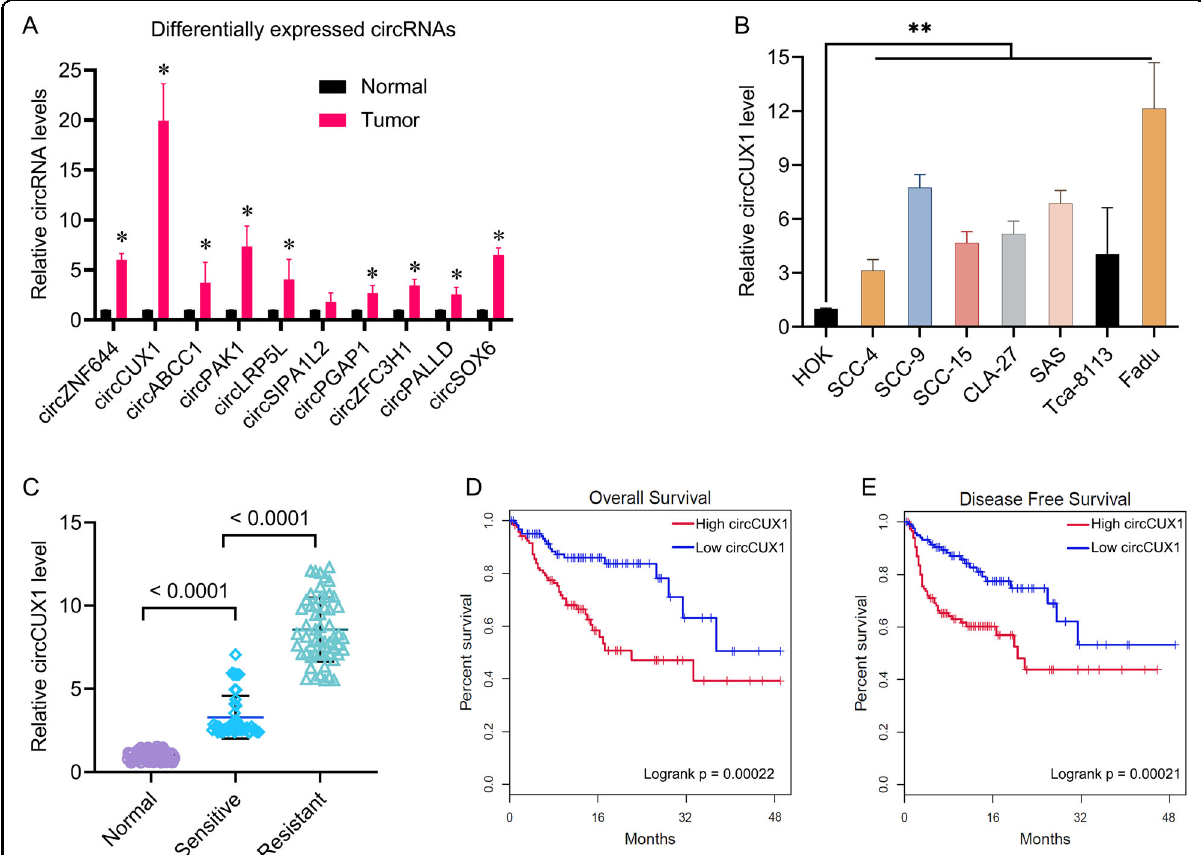
Fig. 2 CircCUX1 was upregulated in HPSCC with radiotherapy resistance. A qRT-PCR analysis of upregulated circRNAs expression in ten HPSCC tissues and matched adjacent normal tissue. * p < 0.05. B qRT-PCR analysis of circCUX1 expression in HOK and seven head and neck tumor cell lines. C qRT-PCR analysis of circCUX1 expression in radiosensitive ( N = 40) and radioresistant ( N = 38) HPSCC tissues and adjacent normal tissue ( N = 60). D Kaplan – Meier analysis of overall survival (OS) in HPSCC patients with low vs. high expression of circCUX1. E Kaplan – Meier analysis of disease-free survival in HPSCC patients with low vs. high expression of